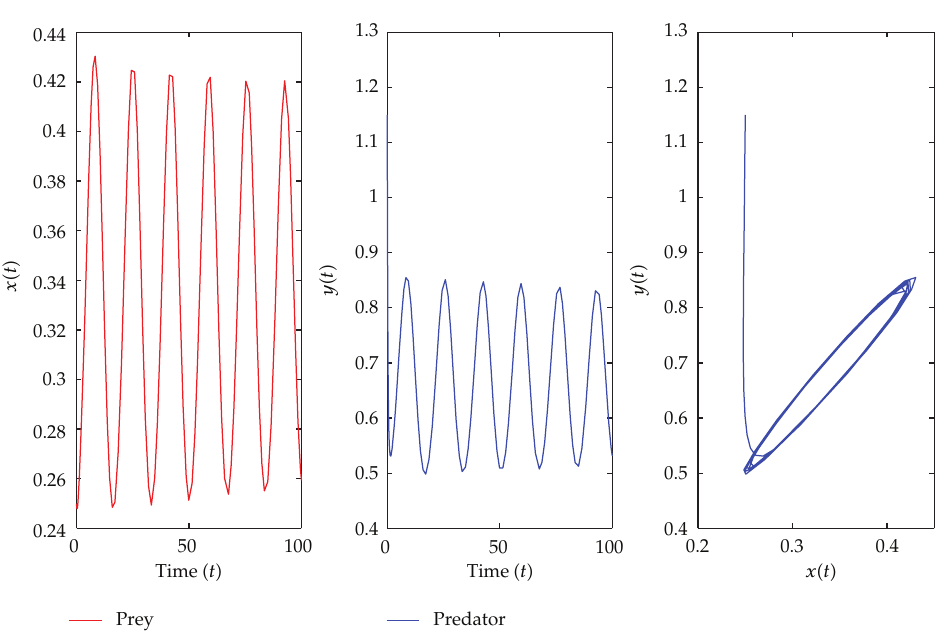
Figure 2: E (cid:7) 0 . 3333 , 0 . 6666 (cid:8) is unstable when τ 1 (cid:6) 4 . 05 > τ 10 (cid:6) 3 . 7457 with initial value 0.25, 1.15.